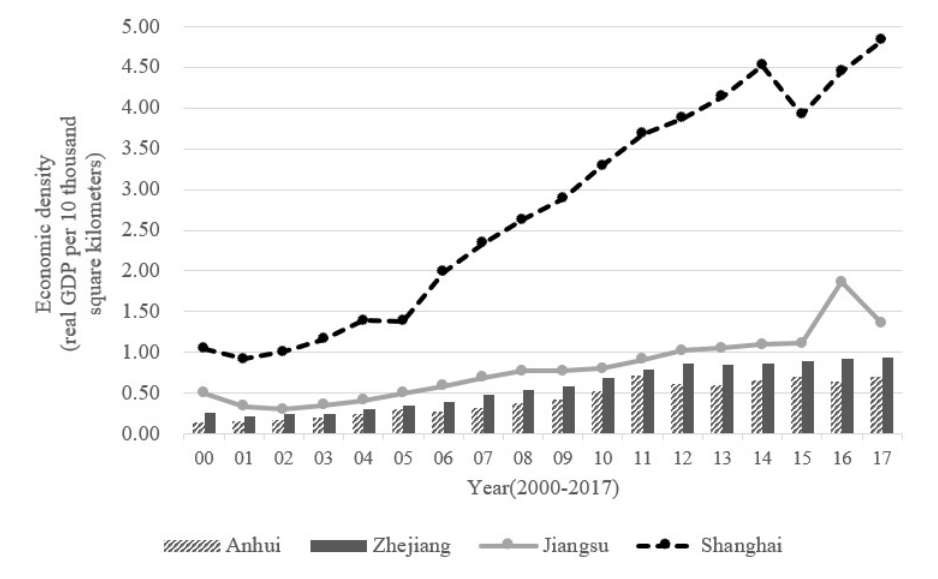
Figure 3. Economic density in the YRD